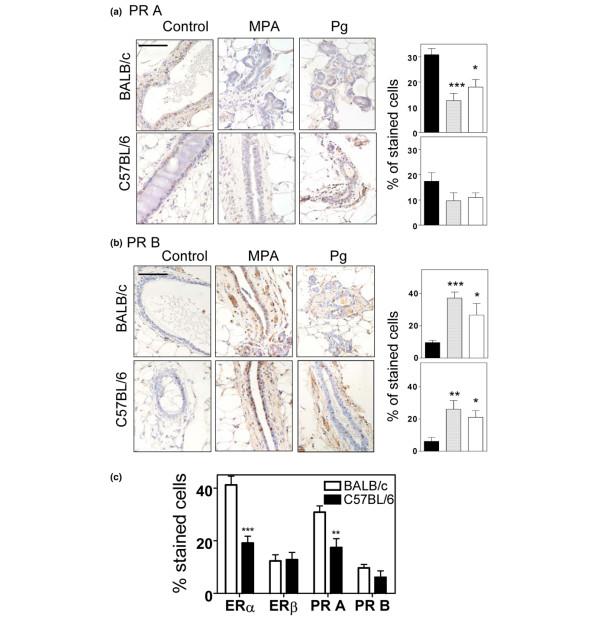
PR expression in mammary glands treated with progestins for 2 months: immunohistochemical studies. Control mice received blank silastic pellets. For both (a) PR-A and (b) PR-B, a representative image of four to six histologic slides per group is shown. The number of stained cells is expressed as the percentage of the number of stained cells per epithelial cells in 400× fields of every slide and a minimum of 1,500 epithelial cells/slide were counted (bar: 80 μm). The right panels show the quantification in control (filled columns), MPA-treated (dotted columns), and Pg-treated (empty columns) mice (mean ± standard error). PR-A expression decreased significantly in progestin-treated BALB/c mice, whereas PR-B expression increased in progestin-treated mice of both strains. *P < 0.05, **P < 0.01, ***P < 0.001 control versus treated mice. (c) Quantification (mean ± standard error) of the percentage of positive stained cells for ER-α, ER-β, PR-A, and PR-B in control BALB/c or C57BL/6 female mice shown in Figures 3 and 4a,b. BALB/c mice show higher levels of ER-α and PR-A than C57BL/6 female mice. In control groups, animals were killed at diestrus. ***P < 0.001, **P < 0.01. ER, estrogen receptor; MPA, medroxyprogesterone acetate; Pg, progesterone; PR, progesterone receptor.